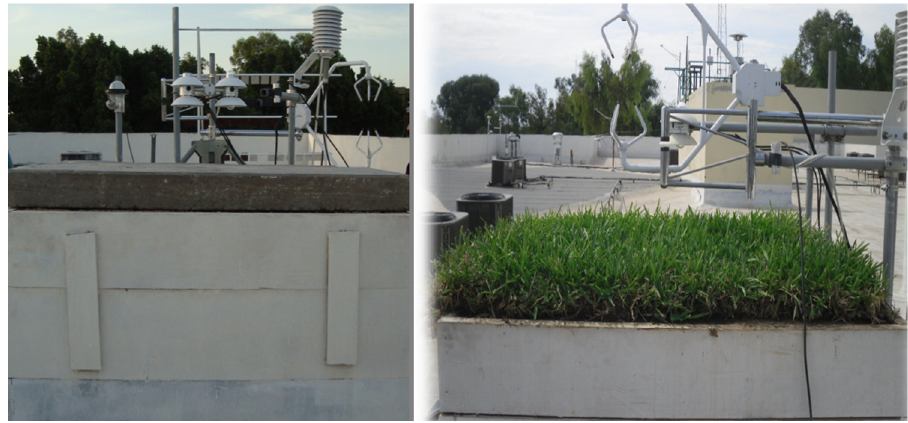
Figure 1. Experimental setting for tests Concrete ( left ) and grass ( right